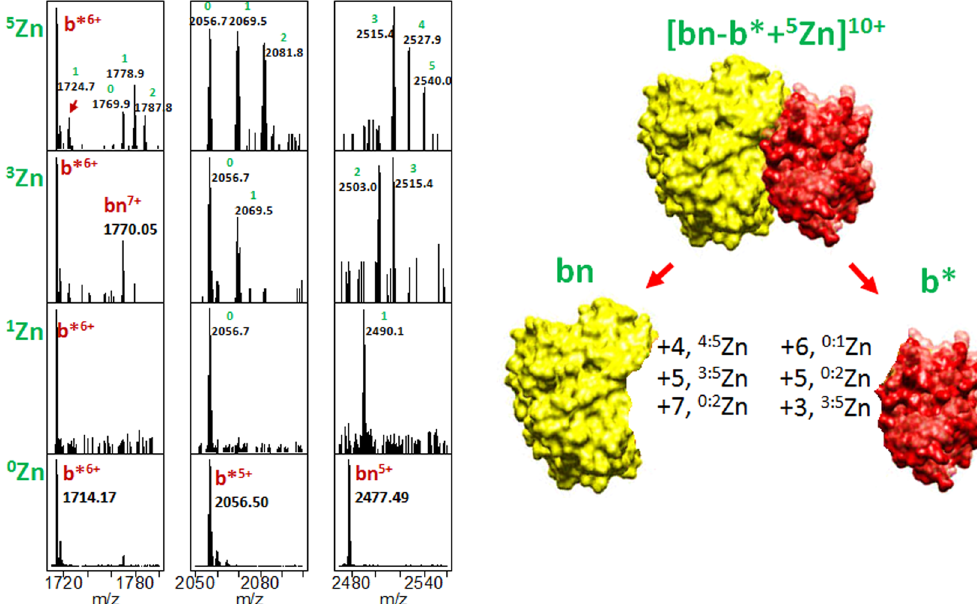
Figure 5. Left - zoomed parts of the fragmentation spectrum of the [bn-b * ] 10 + complex carrying different numbers of Zn atoms. Right – the correlation of charge and Zn distribution between protein monomers. x:y Zn means that ions are carrying from x to y atoms of